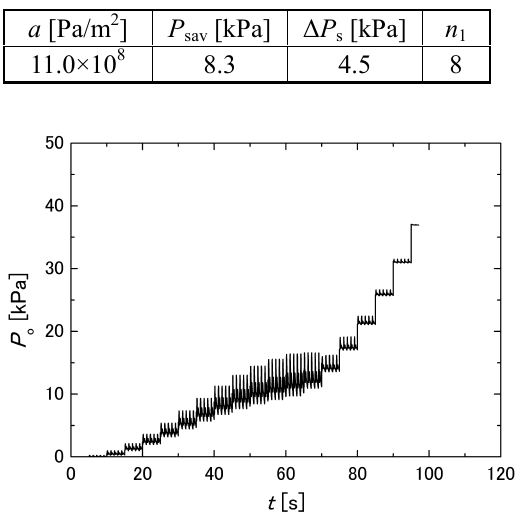
Table 2 Parameters which best fit the experimental data.